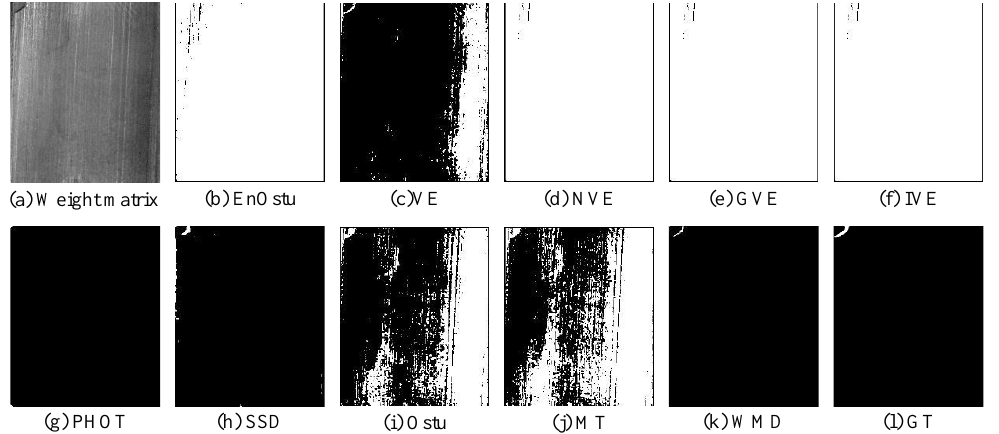
Figure 15. Visual comparisons of detection results using the ten methods on weighed matrix of magnetic tile images. EnOstu, VE, NVE, GVE, IVE, PHOT, SSD, Ostu, and MT cannot effectively identify defects. VE only identifies some defects, and our method (WMD) can effectively provide the location of defect.